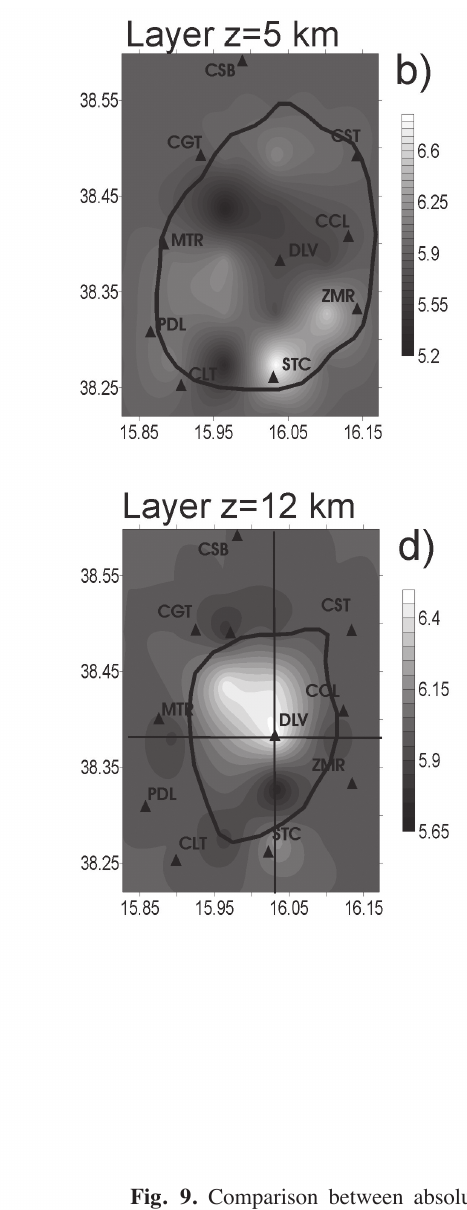
Fig. 9. Comparison between absolute P-wave ve- locity values (a-d) for the layers centred on 2, 5, 9 and 12 km depth (modified after Raffaele et al. , 2006) and Q P values (e) obtained along the source- to-receiver path at each station. The thick black contour denotes the limit of reliable resolution. In a structures are indicated with dotted white